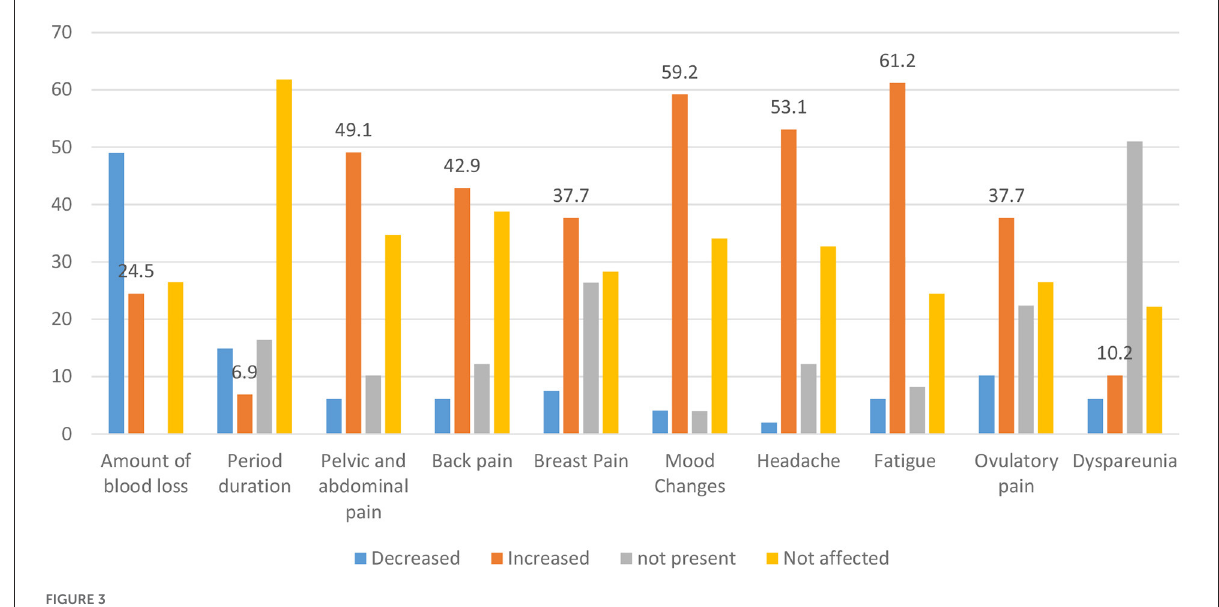
FIGURE3 Changes in the menstrual related symptoms among COVID-19 cases.